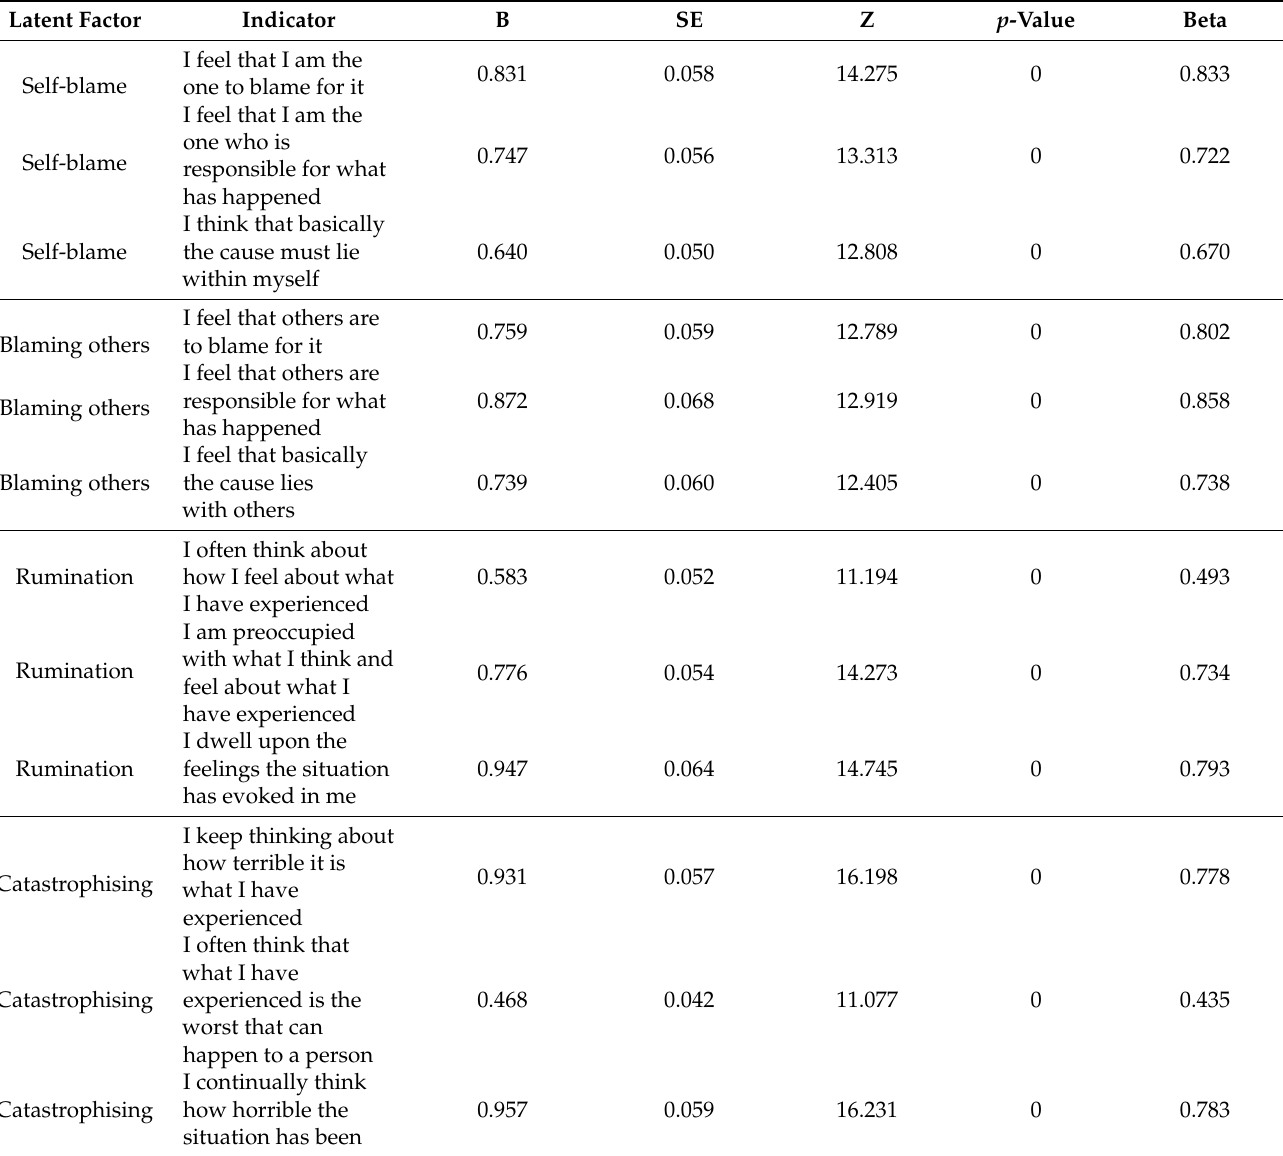
Table 2. Estimates of the nine-factor solution (maladaptive